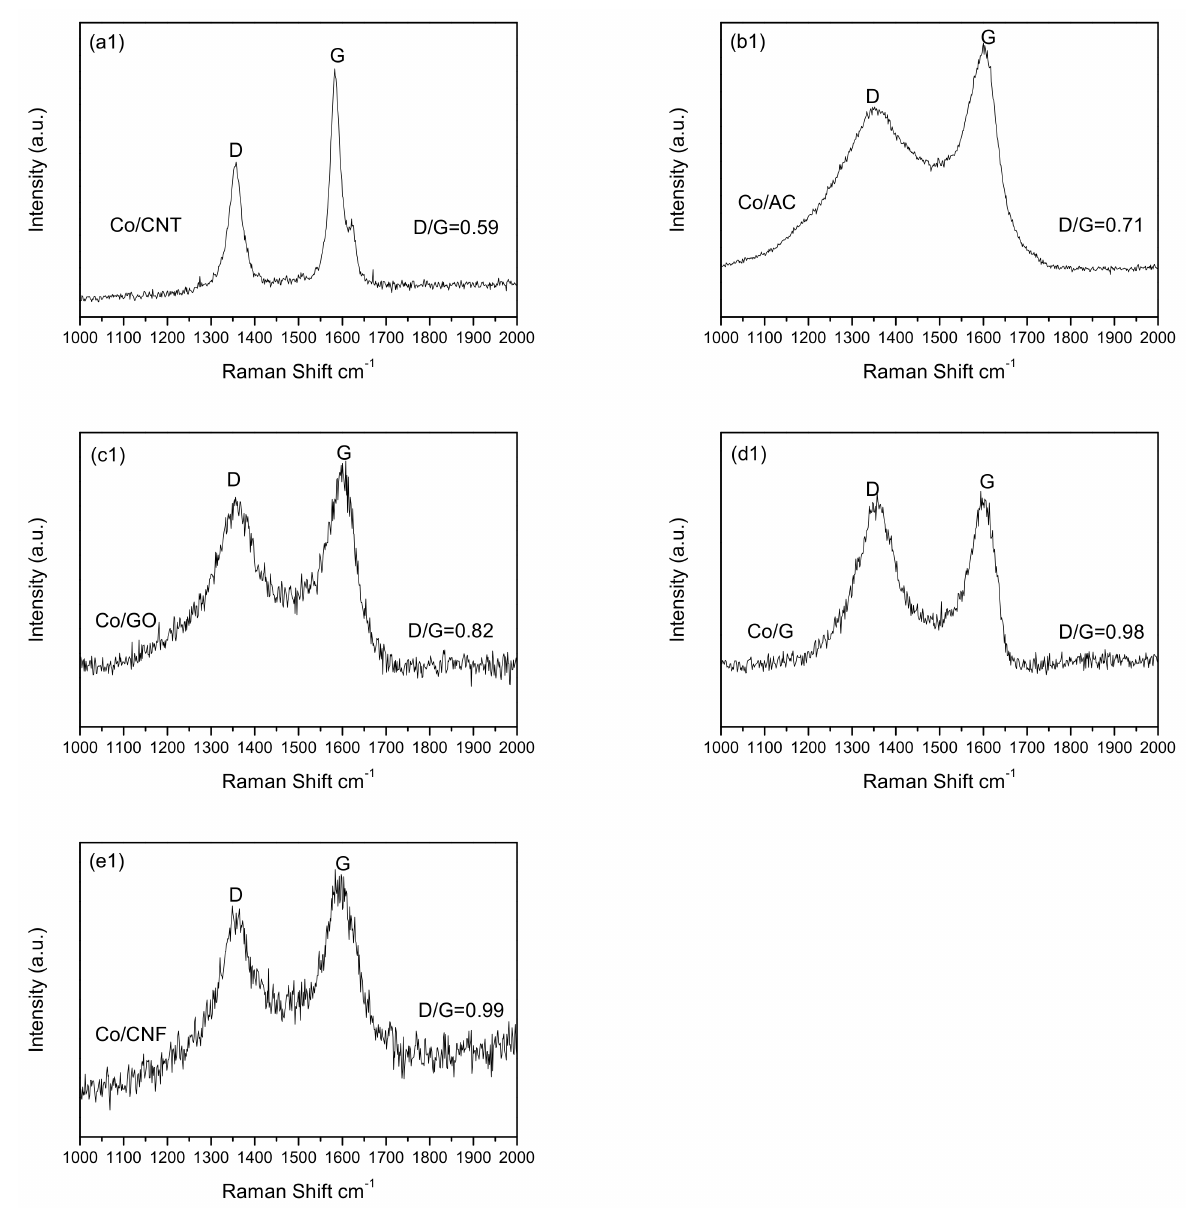
Figure 6. Raman spectroscopy results of different carbon-supported cobalt catalysts. ( a1): Co/CNT, ( b1) : Co/AC, ( c1) : Co/GO, ( d1) : Co/rGO, ( e1) :